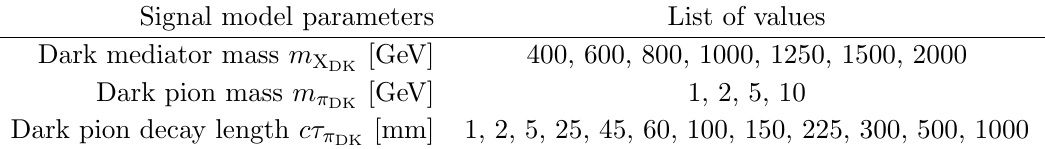
Table 1 . Parameters used in generating the 336 simulated signal event samples. A sample corre- sponding to a single model was created for each possible set of parameter